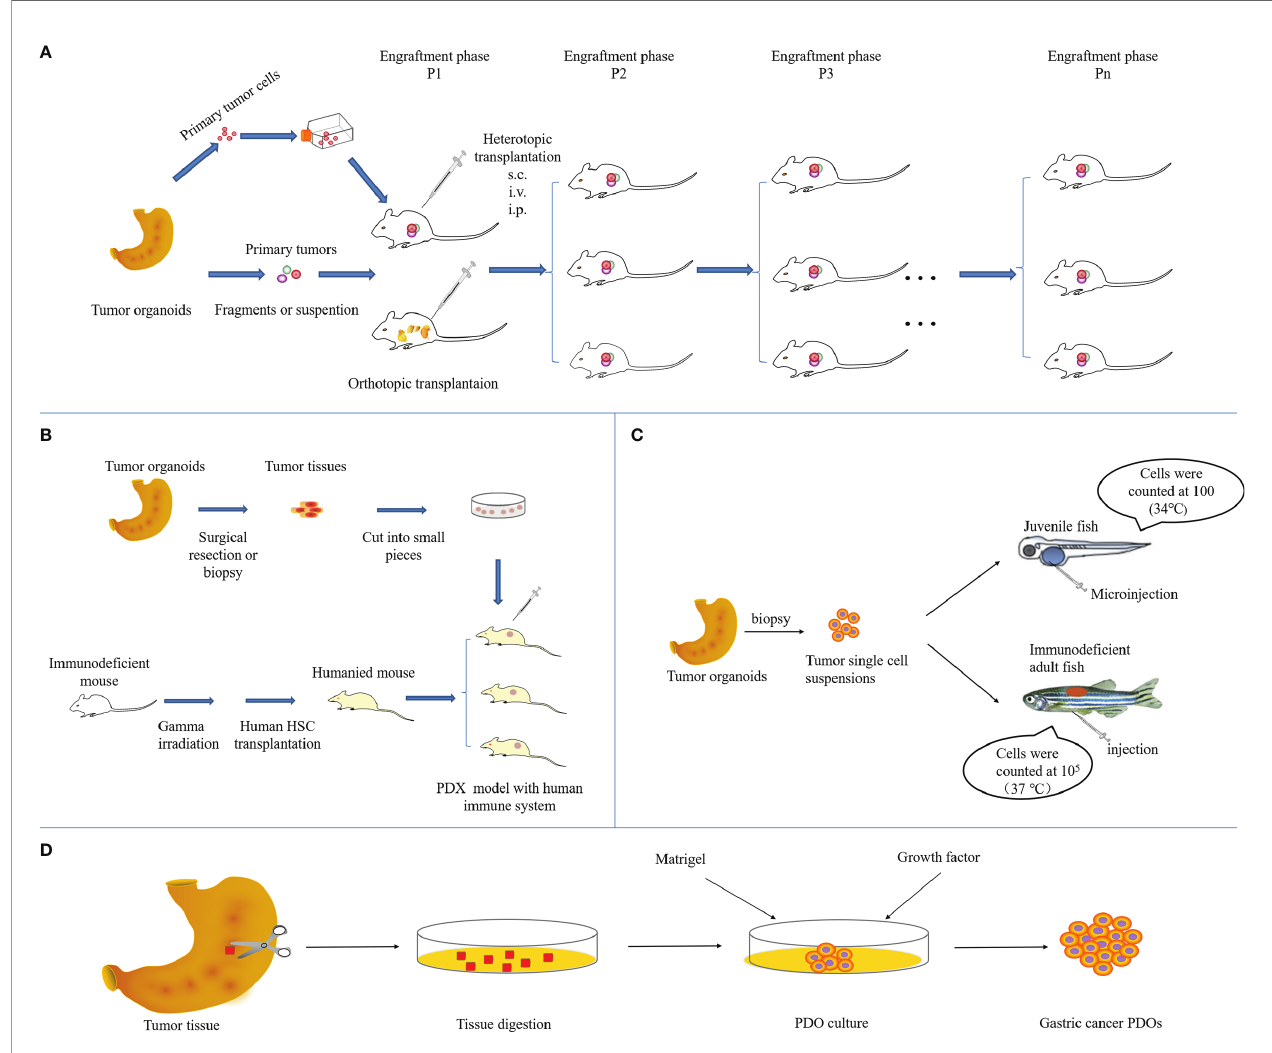
FIGURE 2 | Overview of the methodology to establish GCPDX in (A) immunode fi cient mice, (B) humanized mice, (C) zebra fi sh, and (D) in vitro